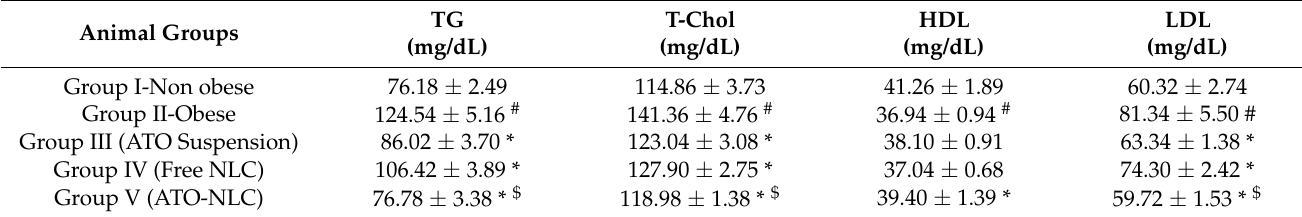
Table 6. The evaluated biochemical parameters following treatment with ATO